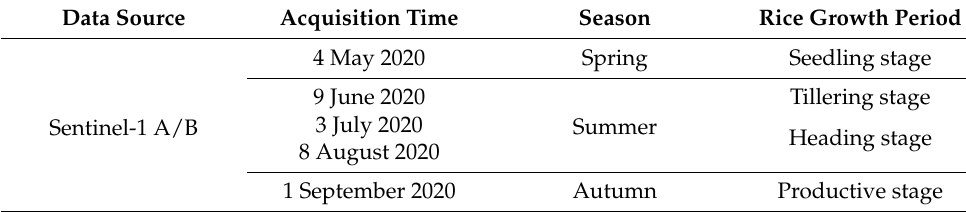
Figure 3. Rice status during the different growth periods. Table 2. The Sentinel-1 data used for training the proposed model.